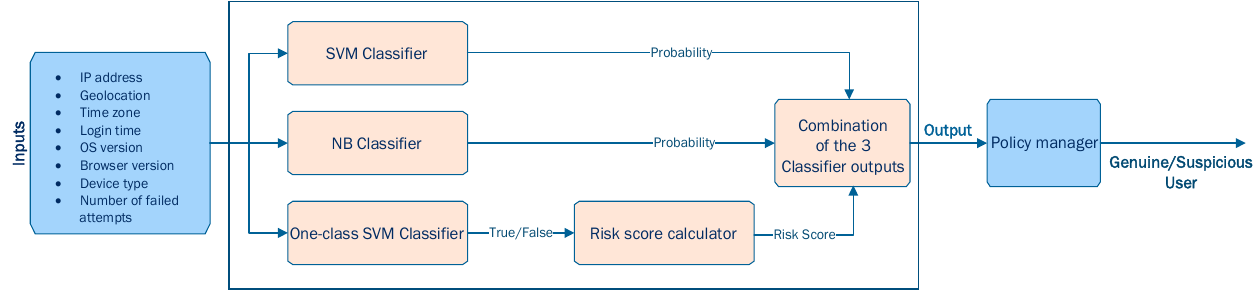
Figure 8. The architecture of the Risk Engine proposed in [49].